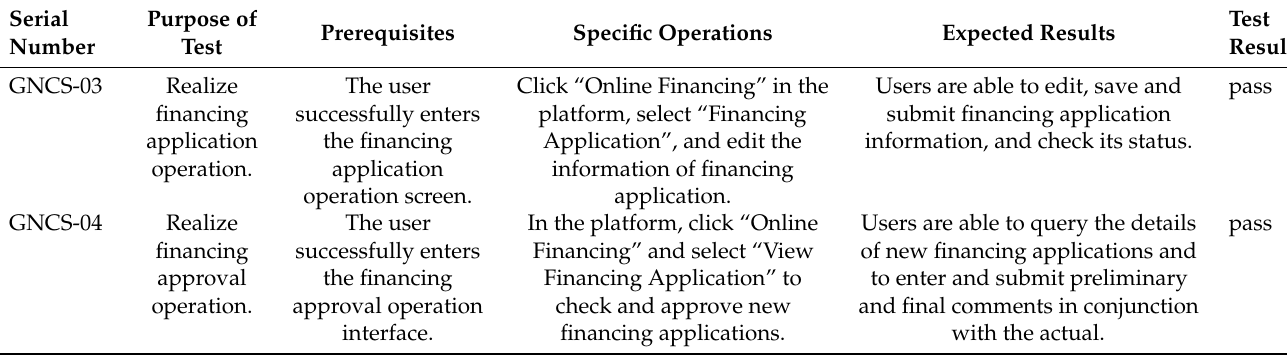
Table 3. Online financing module function test case